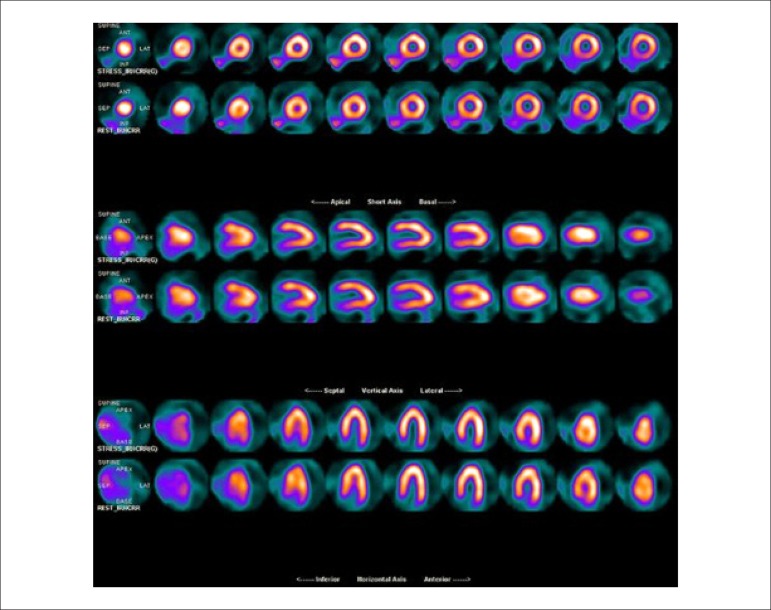
Case 6 - Myocardial perfusion scintigraphy within normality, with two image acquisition series, resting and stress, with dedicated cardiac equipment (gamma camera), equipped with conventional sodium iodide crystals.